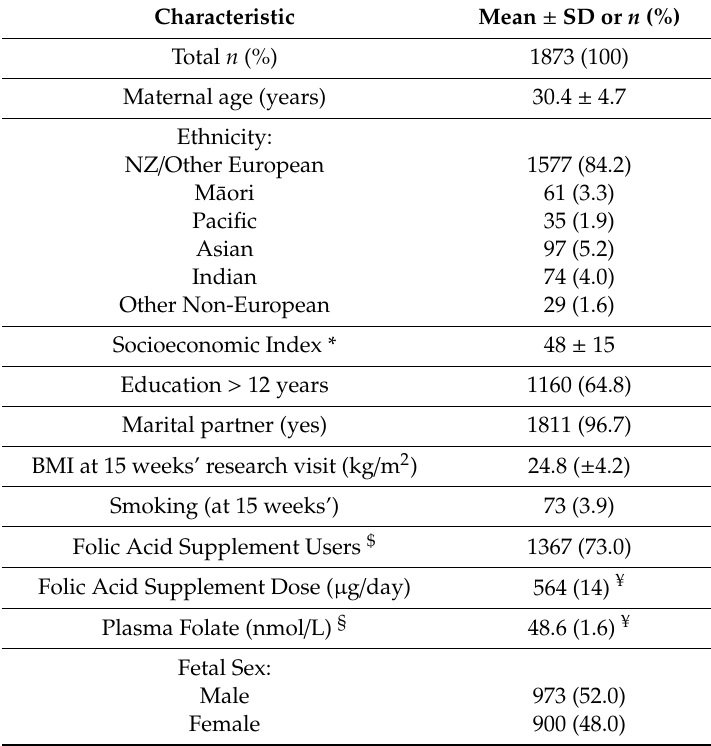
Table 1. Participant Characteristics.